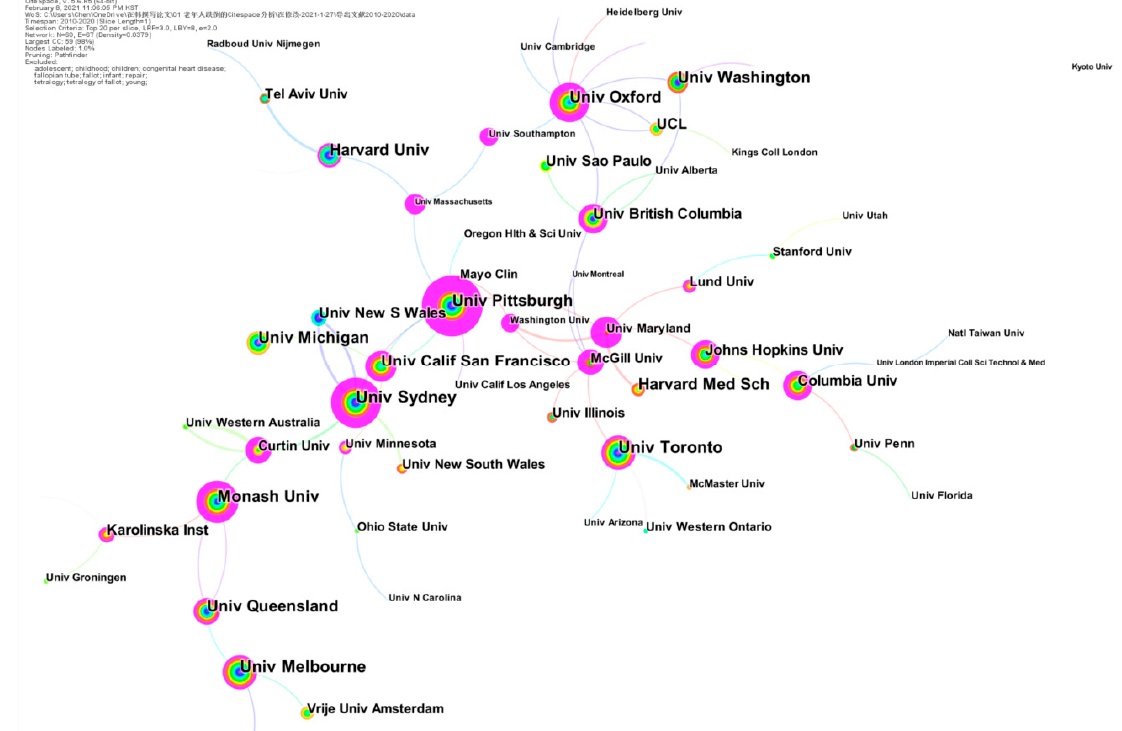
Figure 2. Co-institutions’ network (2010–2020). The color of the circle represents when the article was published. The larger the node diameter, the more papers institutions have published. The thicker the line between the nodes, the closer the two institutions work together.